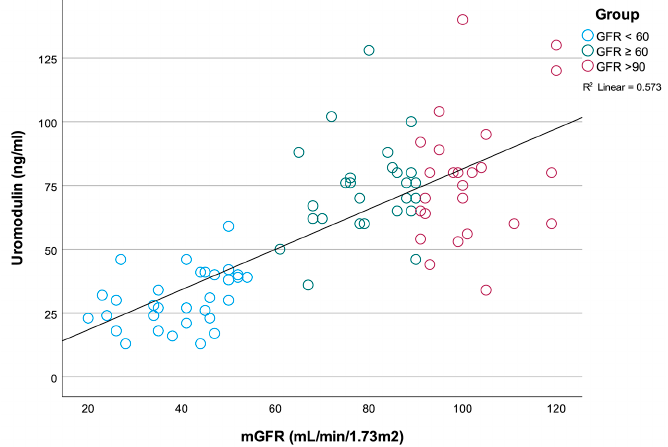
Figure 1. Correlation between sUmod concentration and mGFR. Table 4. Multivariate analysis with sUmod being the dependent variable.